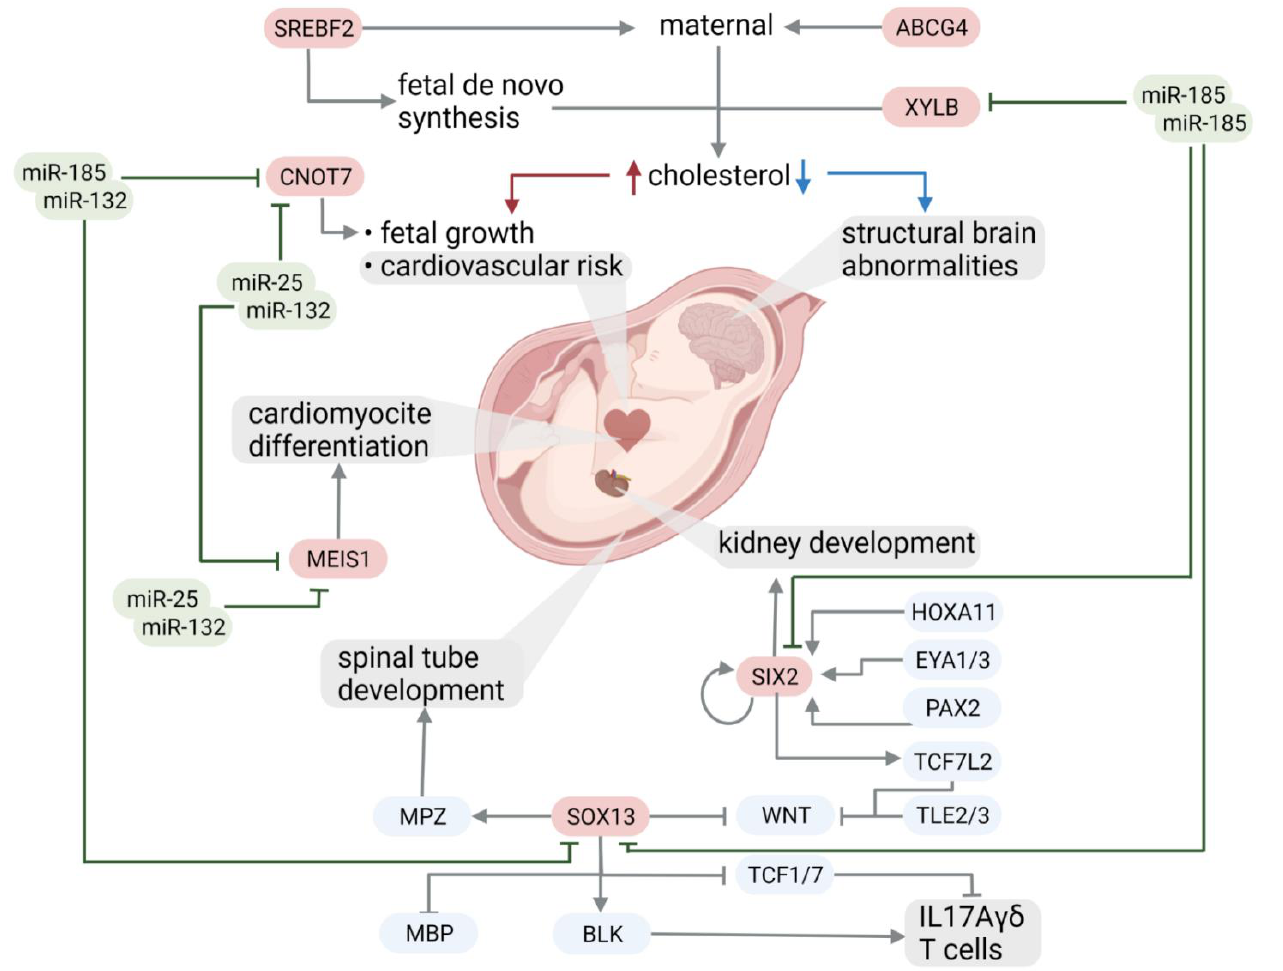
Figure 6. Targets of synergistically working miRNAs and their function. The created miRNA-gene target-transcription factor network, filtered for GO biological function terms neuron death, regulation of lipid biosynthetic process, heart process, and response to decreased oxygen levels revealed a highly interconnected subnetwork. To identify regulatory factors, this subnetwork was filtered for genes falling into more than one GO term of interest. The remaining genes still show high interconnectedness, including sharing interactions with SREBP-2, which has been indicated as a target of synergistically working miRNAs (Figure 4). These elements are thus indicated as regulatory elements for the exhibited phenotype and deserve further study as biomarkers and therapeutic targets for FGR [28].